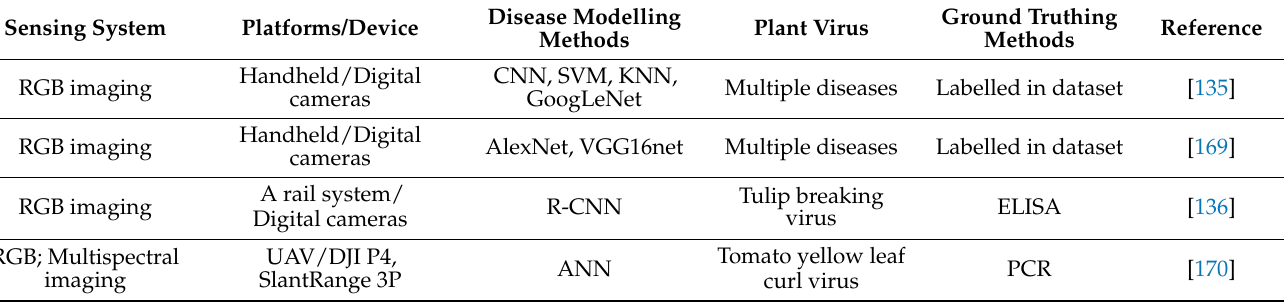
Table 1. Examples of studies on detecting plant viral disease using different optical sensing technolo- gies and modelling